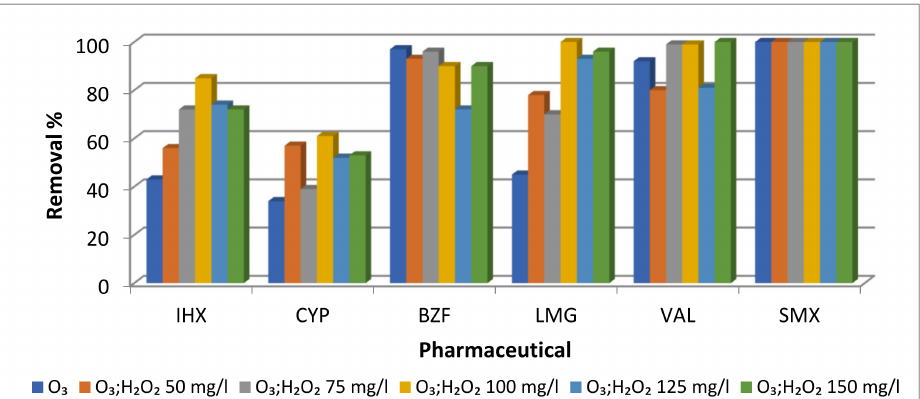
Figure 1. Removal percentages of the six pharmaceutical compounds (PCs) by direct ozonation and indirect ozonation with varying amounts of H 2 O 2 after 20 min. PCs: iohexol (IHX), bezafibrate (BZF), lamotrigine (LMG), valsartan (VAL), cyclophosphamide (CYP) and sulfamethoxazole